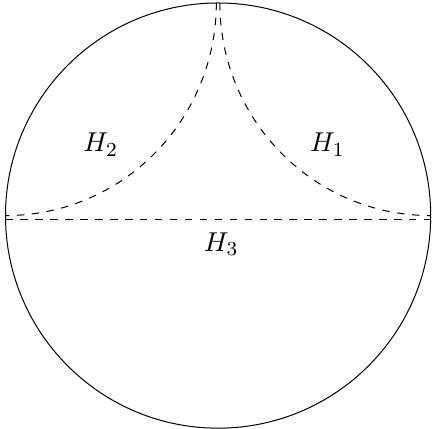
Figure 13. The three-boundary wormhole in the hot limit under our alternative construction with α 1 = − α 2 = α, β 1 = − β 2 = β = π of distinct generators become close to each other in this limit, but each asymptotic region remains a finite